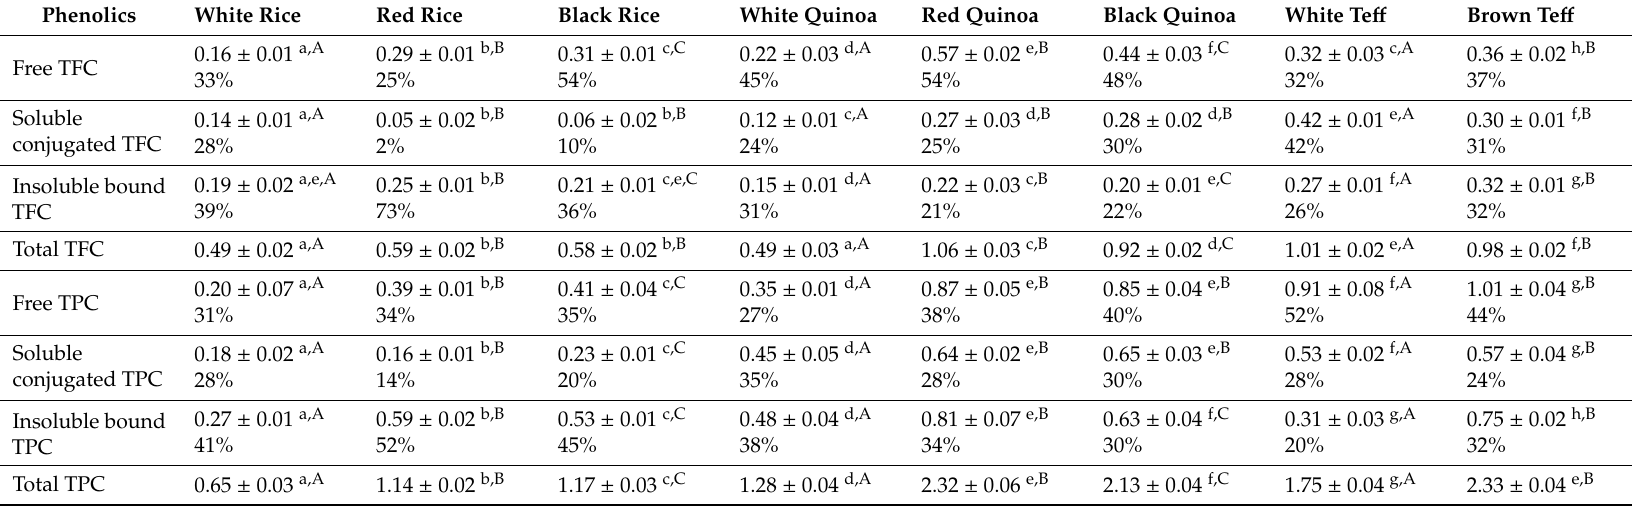
Table 2. Results of total flavonoid and phenolic contents in free, soluble conjugated and insoluble bound phenolic fractions of non-traditional flakes.